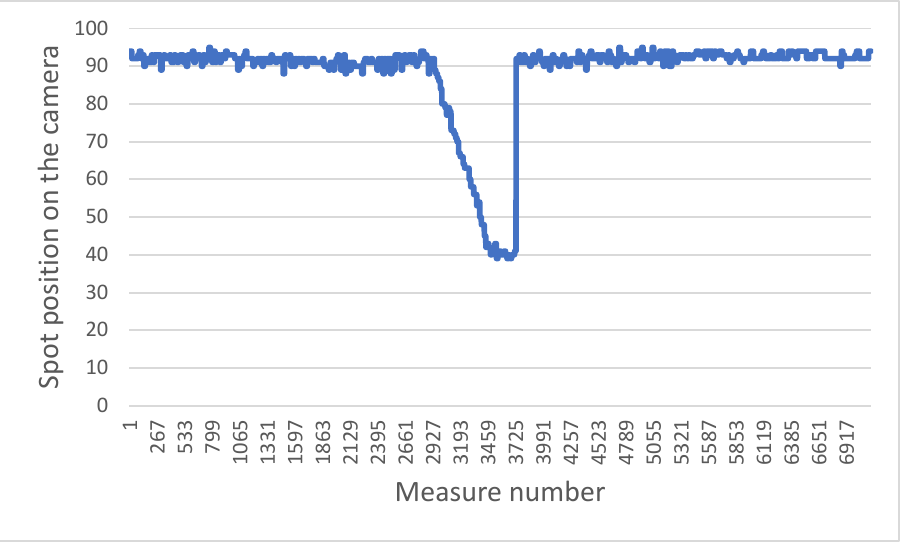
Figure 13. Evolution of position measured while the wheelchair moves toward a cardboard box on the ground, then exceeds it.